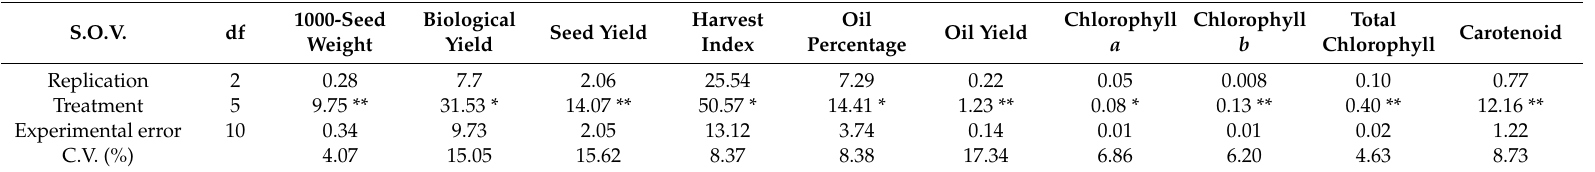
Table 5. Analysis of variance for the e ff ect of di ff erent fertilizer sources on Syrian cephalaria agrobiological properties.